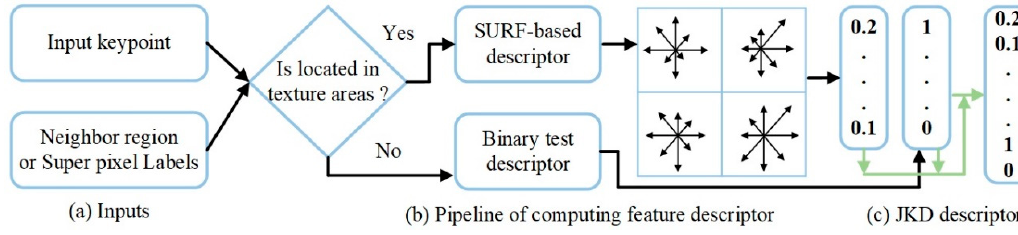
Figure 4. Flowchart of joint keypoint computing.